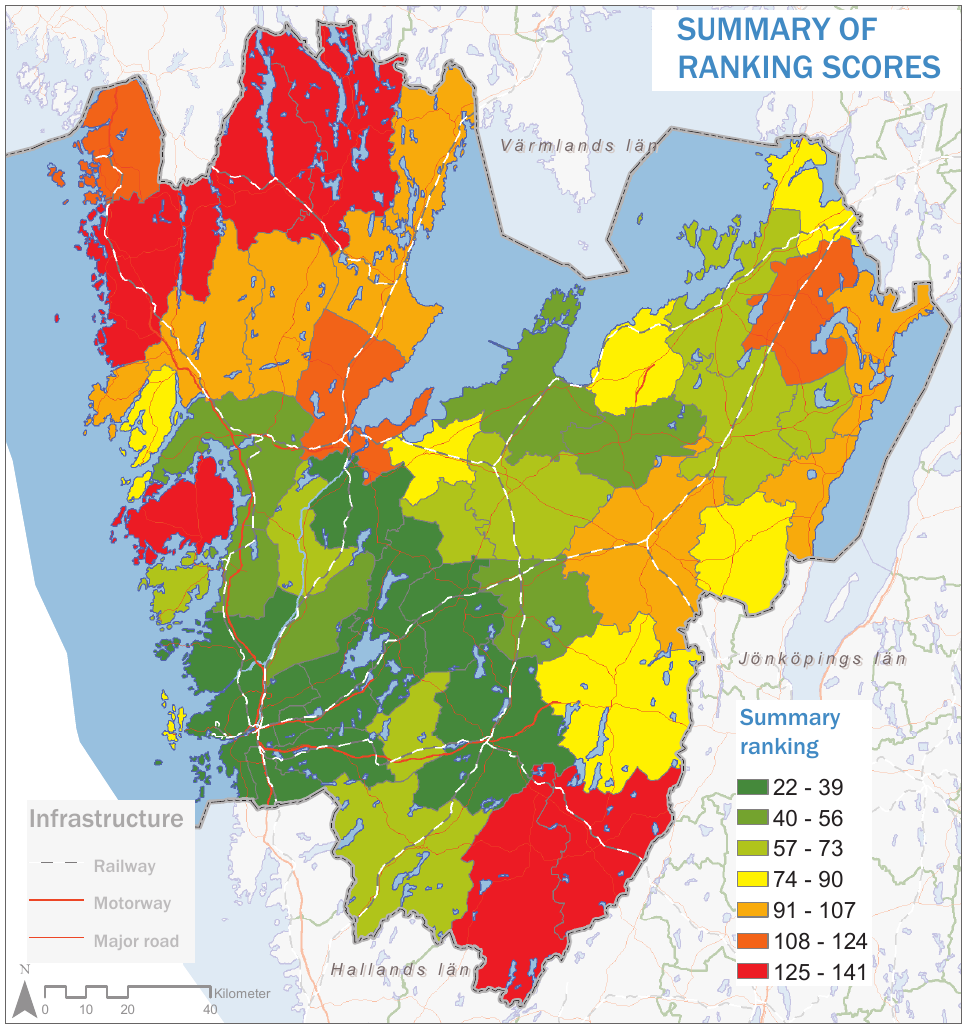
Figure 10: Illustration of the summary ranking scores per